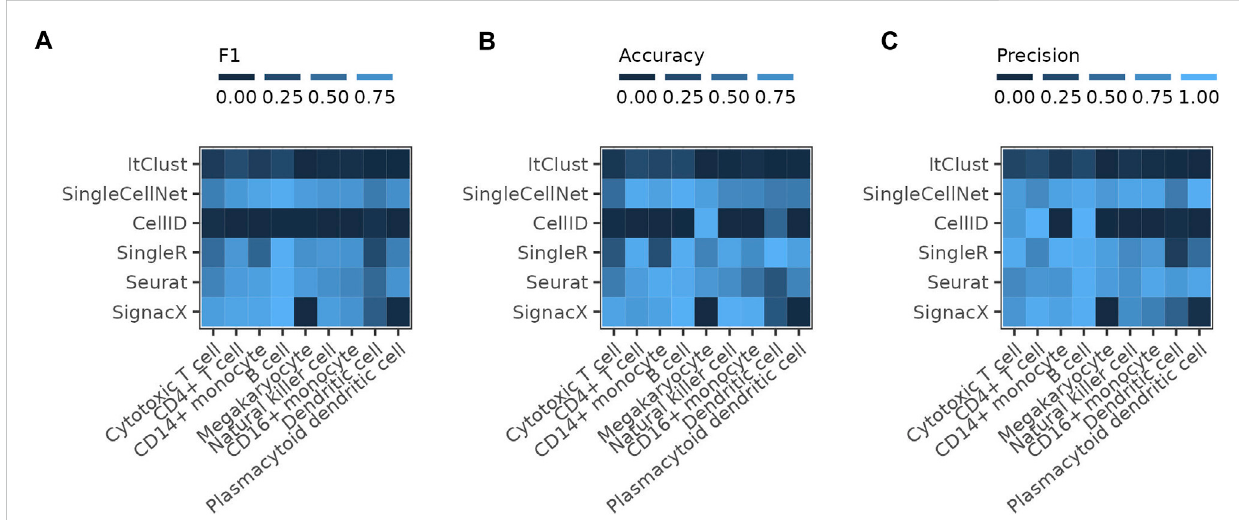
FIGURE 4 ComparingSignacXtotheothermethodsThe fi gureshowsthe (A) F1score, (B) accuracyand (C) precisionoftheindividualmethodsreachedonthe full PBMC reference dataset compared to the results achieved by SignacX on the pre-trained model for immune cell type prediction on the Human Primary Cell Atlas (HPCA) reference